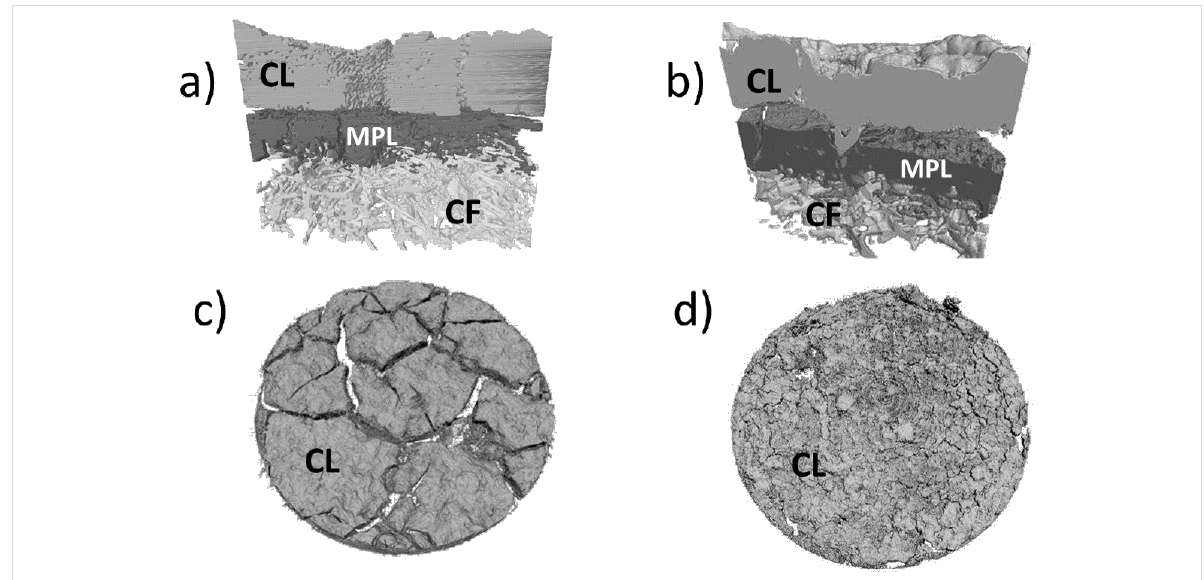
Figure 16: 3D rendering of the X-ray microtomography data for the electrode cross section (a) coated electrode (b) sprayed electrode. 3D rendering of the X-ray microtomography data for the electrode surfaces (c) coated electrode (d) sprayed electrode. CL, MPL, and CF stand for catalyst layer, microporous layer, and carbon felt, respectively. Reprinted with permission from [12]. Copyright 2014